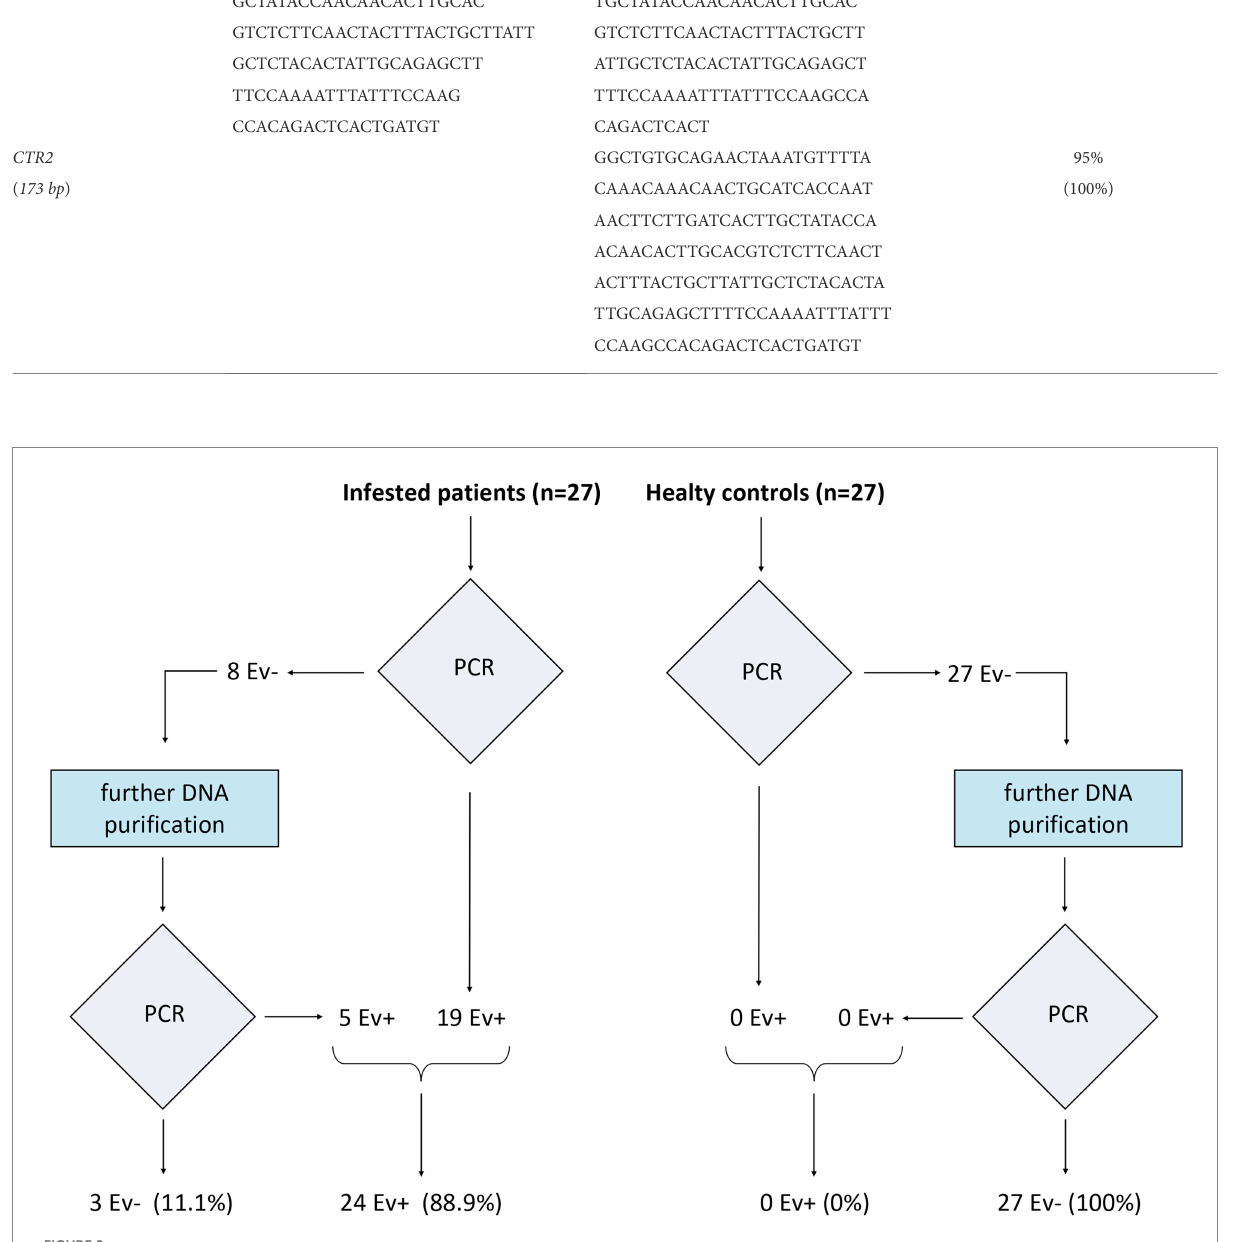
FIGURE 8 Nested PCR in the study population. On the left are reported the results in the infested patients, while on the right there are those in healthy